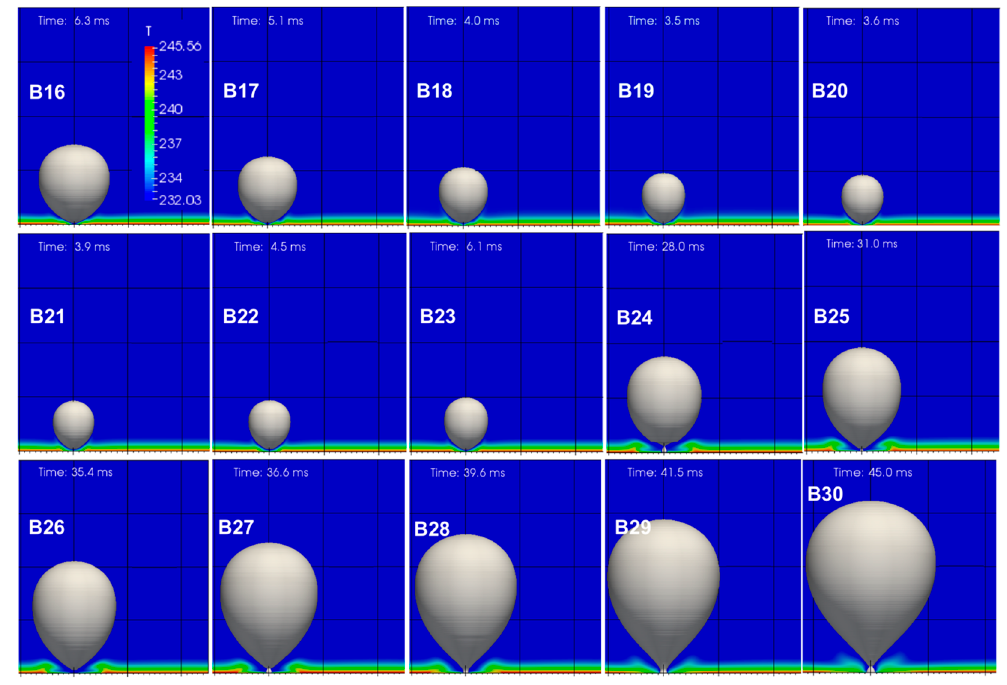
Figure 15. Spatial evolution of generated bubble at the time of detachment for each case R22 of the Series B parametric numerical simulations. Energies 2017 , 10 , 272